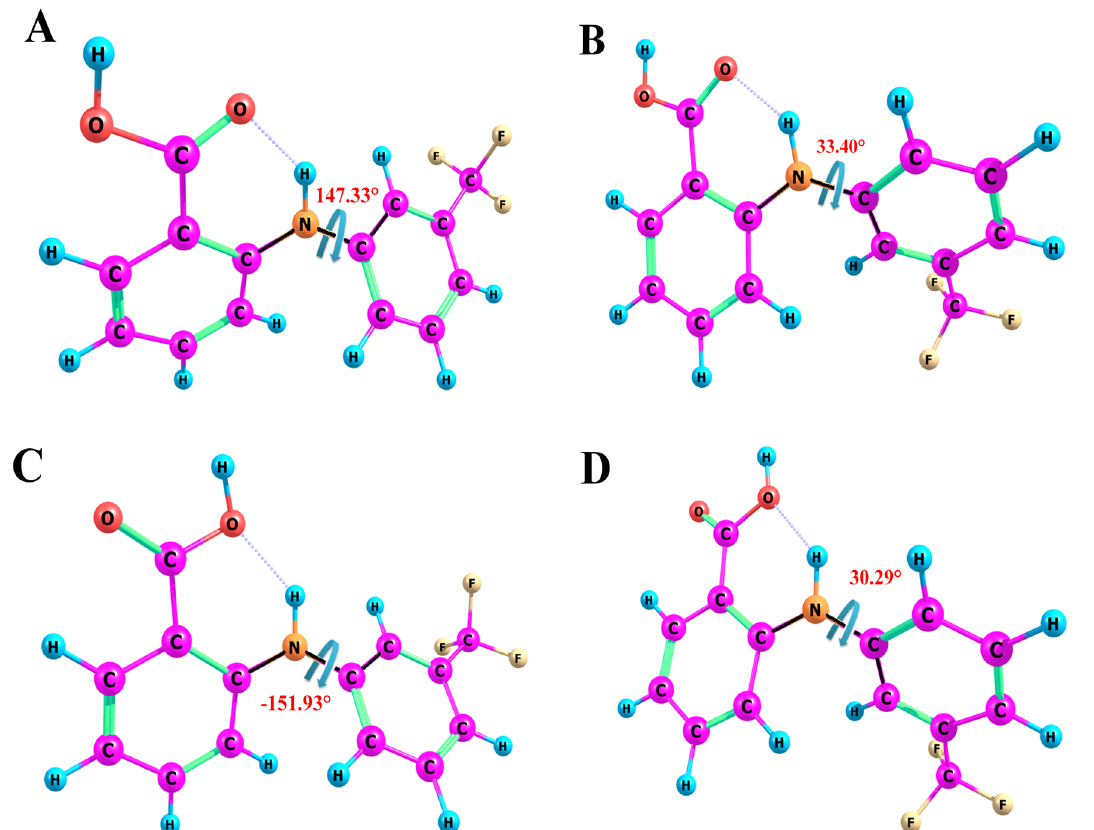
Figure 3. Structures of FFA molecule conformers with dihedral angles τ 1 [C 2 -N-C 3 -C 7 ] (black high- lights). The four most stable conformers of FFA ( A – D ) with an intramolecular H-bond, which are considered later in the NMR data analysis. Conformers A/C and B/D are distinguished by the rotation of the trifluoromethyl-substituted moiety relative to the remaining part of the molecule. Con- formers A/B and C/D are distinguished by the rotation of the COOH fragment.